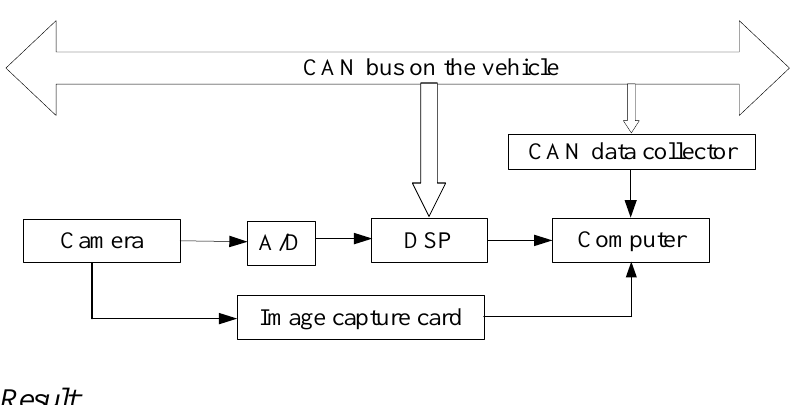
Figure 9. Structure of the experimental